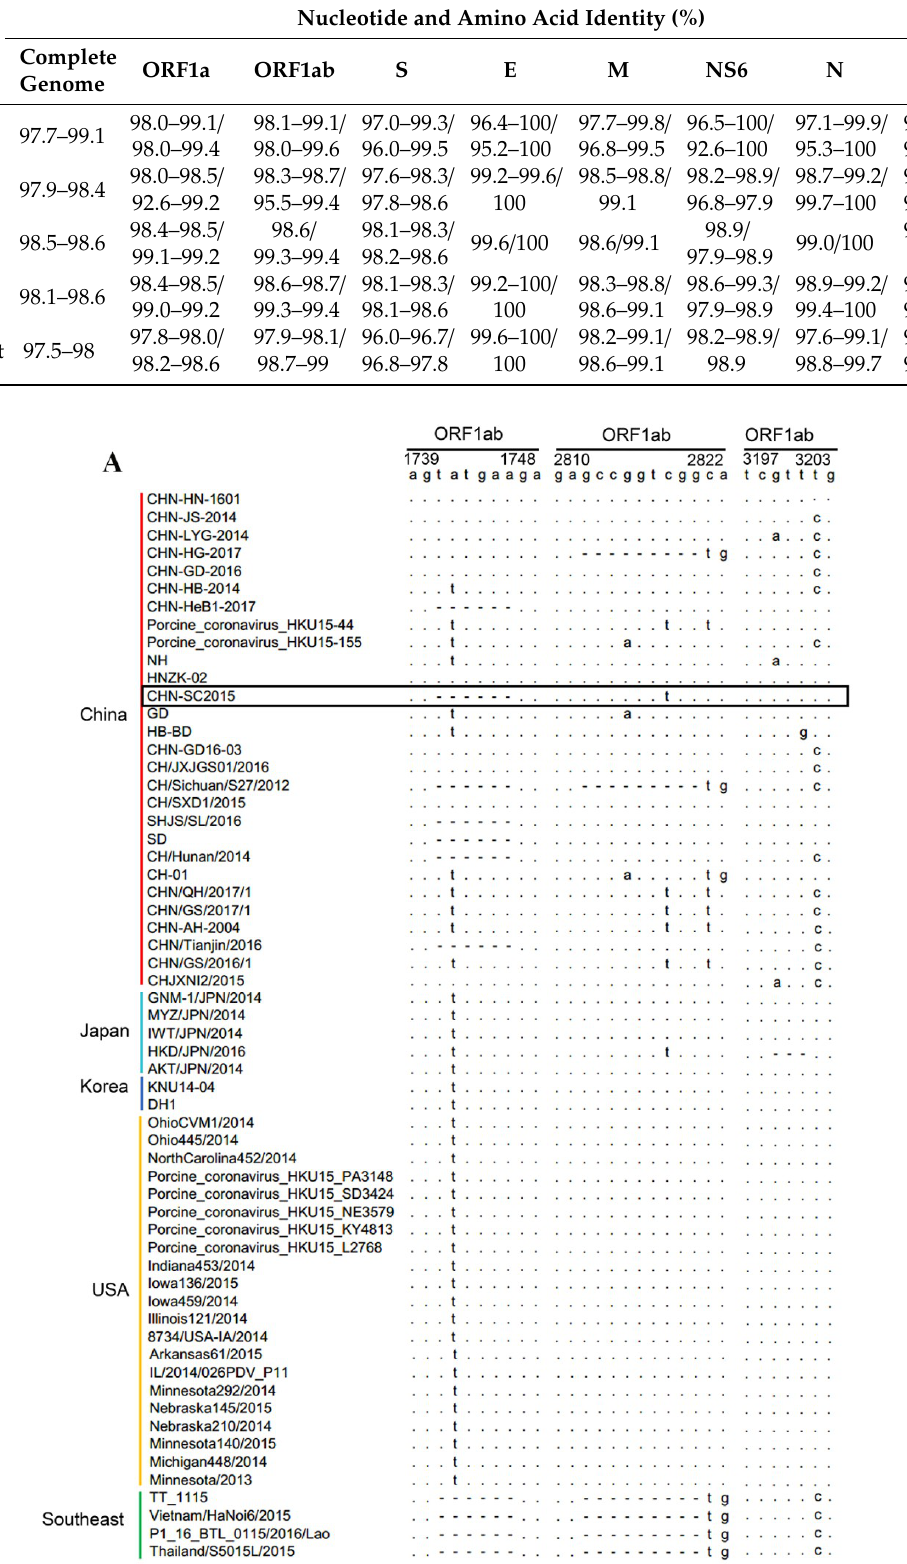
Table 3. Nucleotide and amino acid identity of CHN-SC2015 compared to 59 reference strains in GenBank.